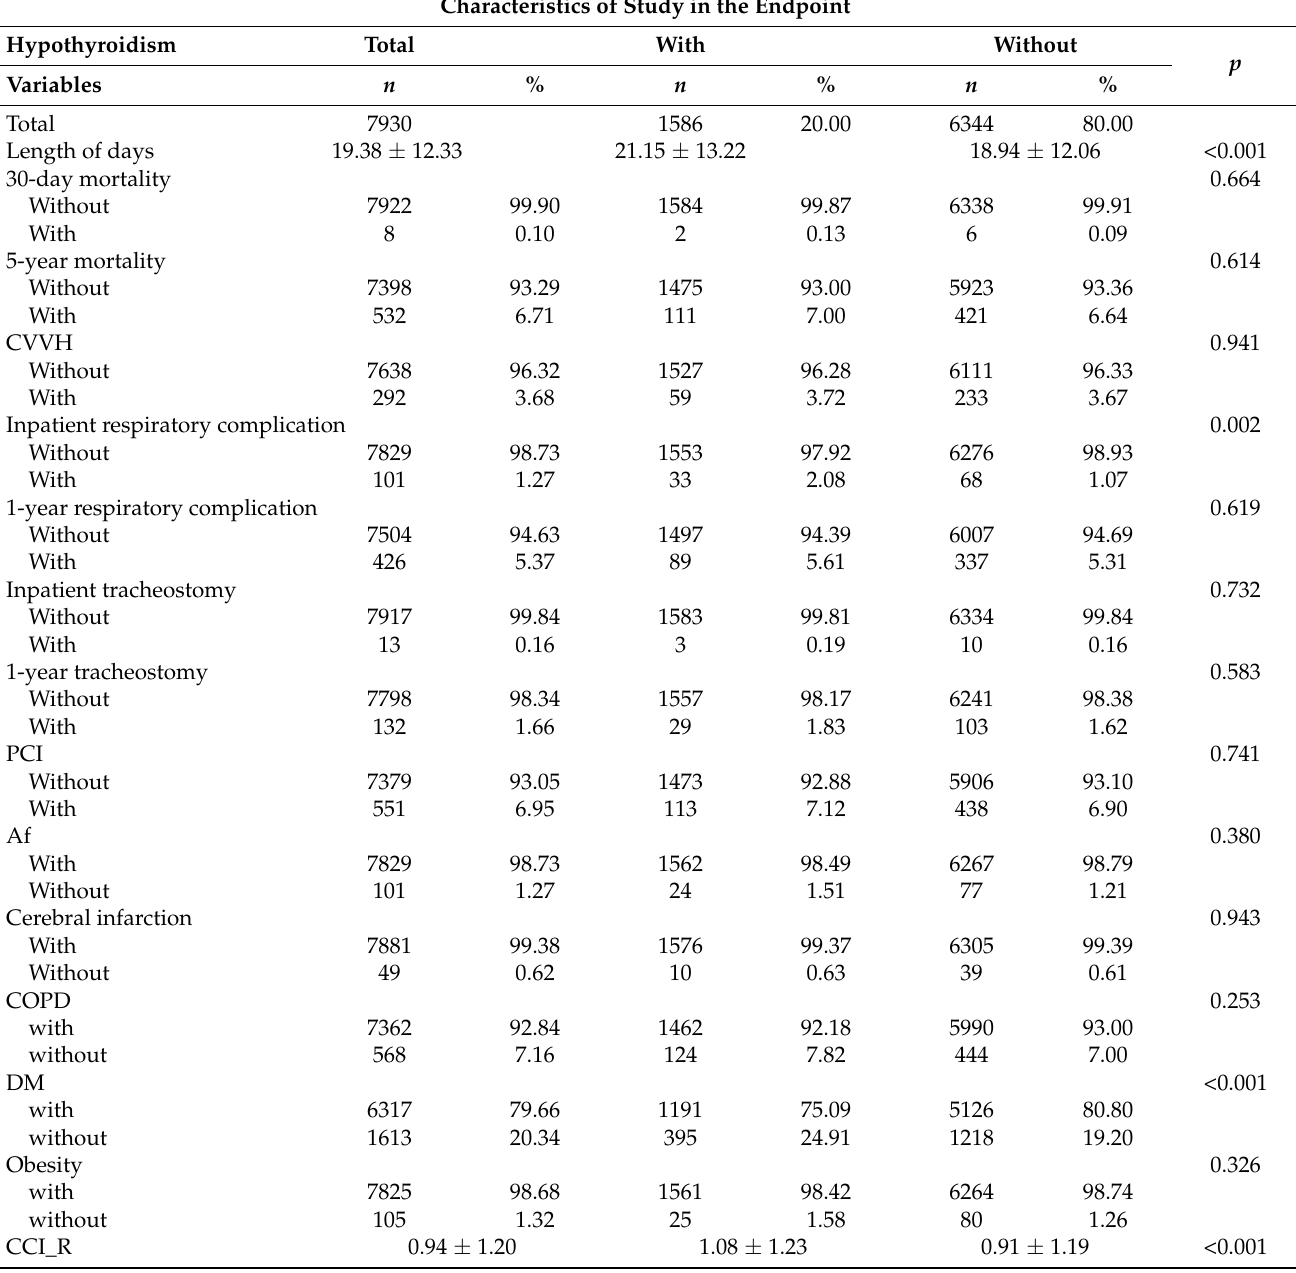
Table 2. Characteristics of study at the